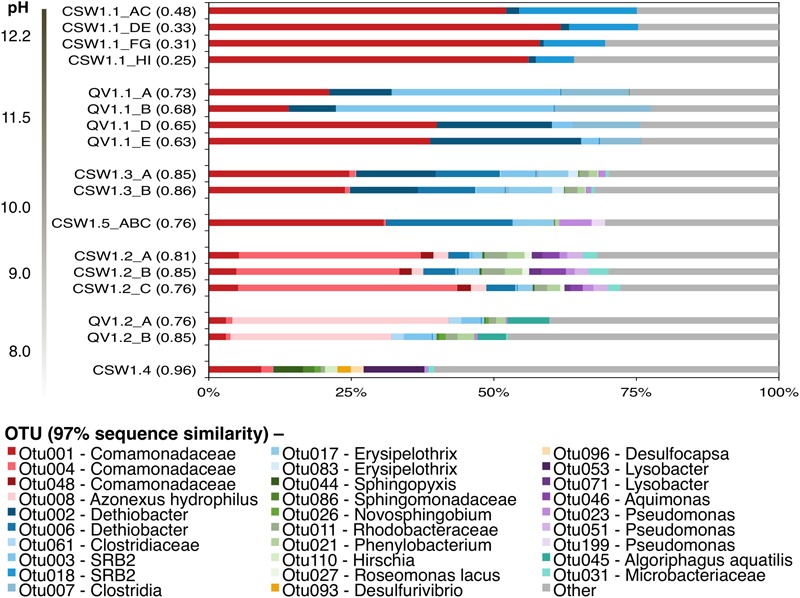
Inter-well community composition comparison from August 2012. OTUs were formed at the 97% similarity level in mothur using the average-neighbor algorithm. Bars indicate individual OTUs and are color-coded by Phlyum/Class: β-proteobacteria (red), Firmicutes (blue), α-proteobacteria (green), δ-proteobacteria (orange), γ-proteobacteria (purple), and Actinobacteria (teal). Other (gray bars) represents any OTUs making up <1% of all samples in the dataset. Samples are organized by pH (ANOSIM: R = 0.66, p-value < 0.05). Replicates represent field replicate samples collected in successive order on the day. The numbers in parentheses beside the sample names represent the Inverse Simpson diversity index.